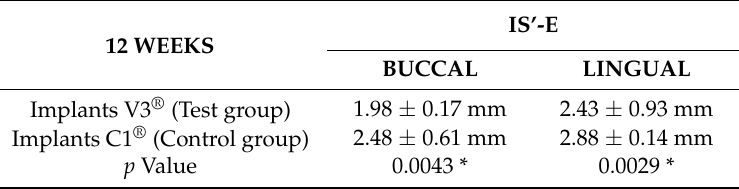
Table 3. Tissue thickness changes between baseline and 12-week study times (measured from the top of the implant shoulder (line IS’) to the most external portion of the tissue (line E)). Tissue thickness loss (mean ± SD); * indicates significant differences ( p < 0.05).